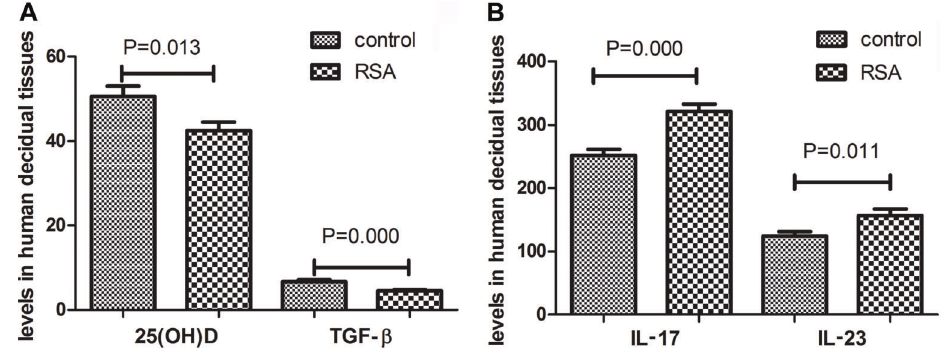
Figure 1. A , Concentrations of 25-hydroxyvitamin D (25(OH) D), transforming growth factor b (TGF- b ), and B , interleukin-17 (IL-17) and interleukin-23 (IL-23) in decidual tissues by enzyme-linked immunosorbent assay, in the recurrent spontaneous abortion (RSA) group compared with the control group. Data are reported as means ± SD. Statistical analysis was done with Student ’ s t -test.